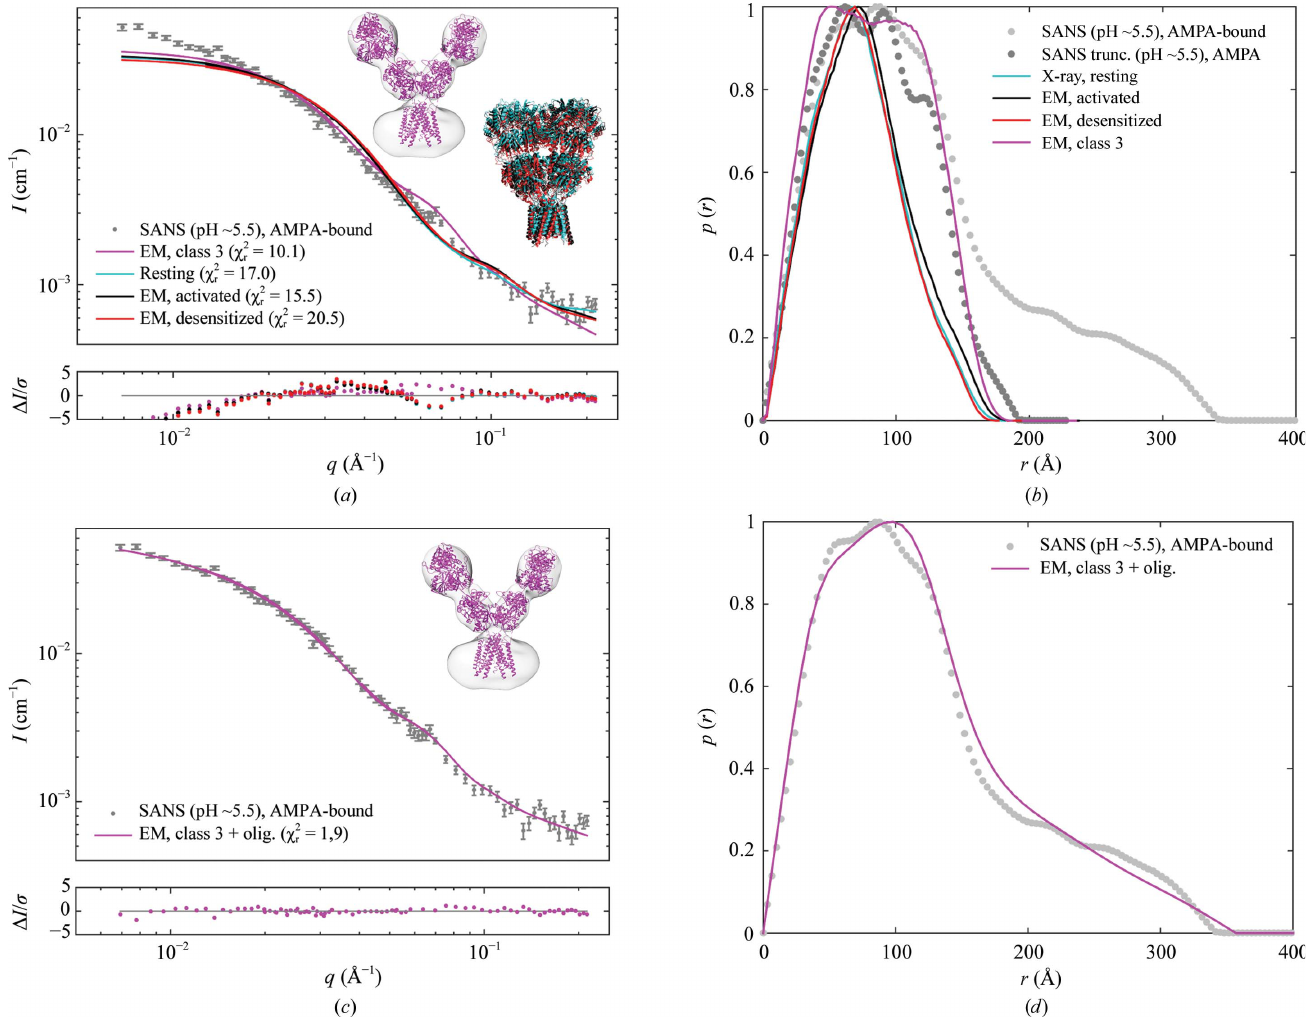
Figure 4 SANS data for GluA2 in the presence of AMPA at pH 5.5. ( a ) Experimental SANS data for GluA2 in the presence of AMPA at pH 5.5 (grey points) and the resulting fits and residual plots of the GluA2 EM structure in the activated state (PDB entry 5weo; black; Twomey et al. , 2017 b ), the EM structure in the desensitized state (PDB entry 5vhz; red; Twomey et al. , 2017 a ), the X-ray crystal structure in the resting state (PDB entry 4u2p; cyan; Du¨rr et al. , 2014) and the class 3 EM structure (EMD-2688; magenta; Meyerson et al. , 2014). Cartoon representations of each of the three atomic resolution structures were aligned and are shown in the respective colours. A cartoon representation of the atomic structure fitted to the EM class 3 density map is also shown. ( b ) p ( r ) functions for the SANS data (light grey points) and for a truncated data set ( q (cid:9) 0.019 A˚ (cid:5) 1 ; dark grey points) together with the theoretical p ( r ) functions for the four structures. ( c , d ) Experimental data (nontruncated; grey points), the resulting fit and the p ( r ) function for a linear combination of the EM class 3 structure and fractal oligomers